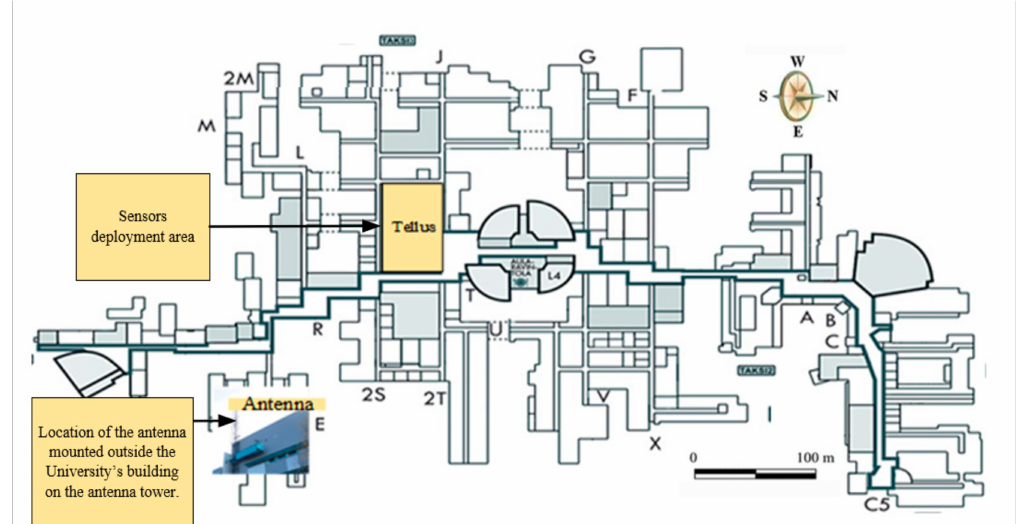
Figure 2. University of Oulu indoor map showing the location of the target area and the gateway.